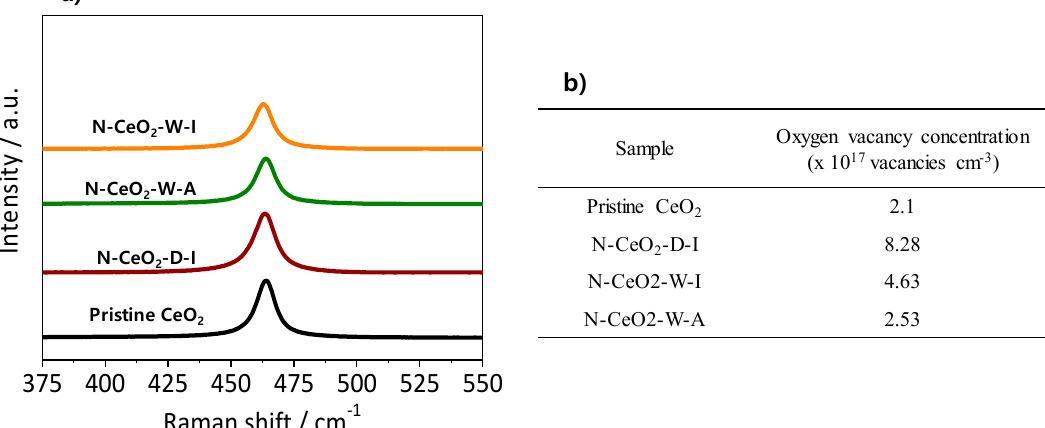
Figure 7. ( a ) Raman spectra of the pristine CeO 2 and the La-doped CeO 2 NPs. ( b ) Oxygen vacancy concentration on the samples estimated by the Raman spectroscopy.